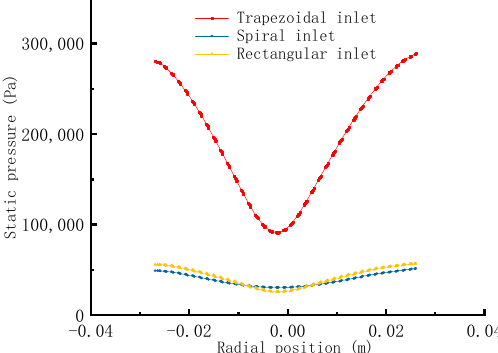
Figure 8. Static pressure distribution curve of section Z.